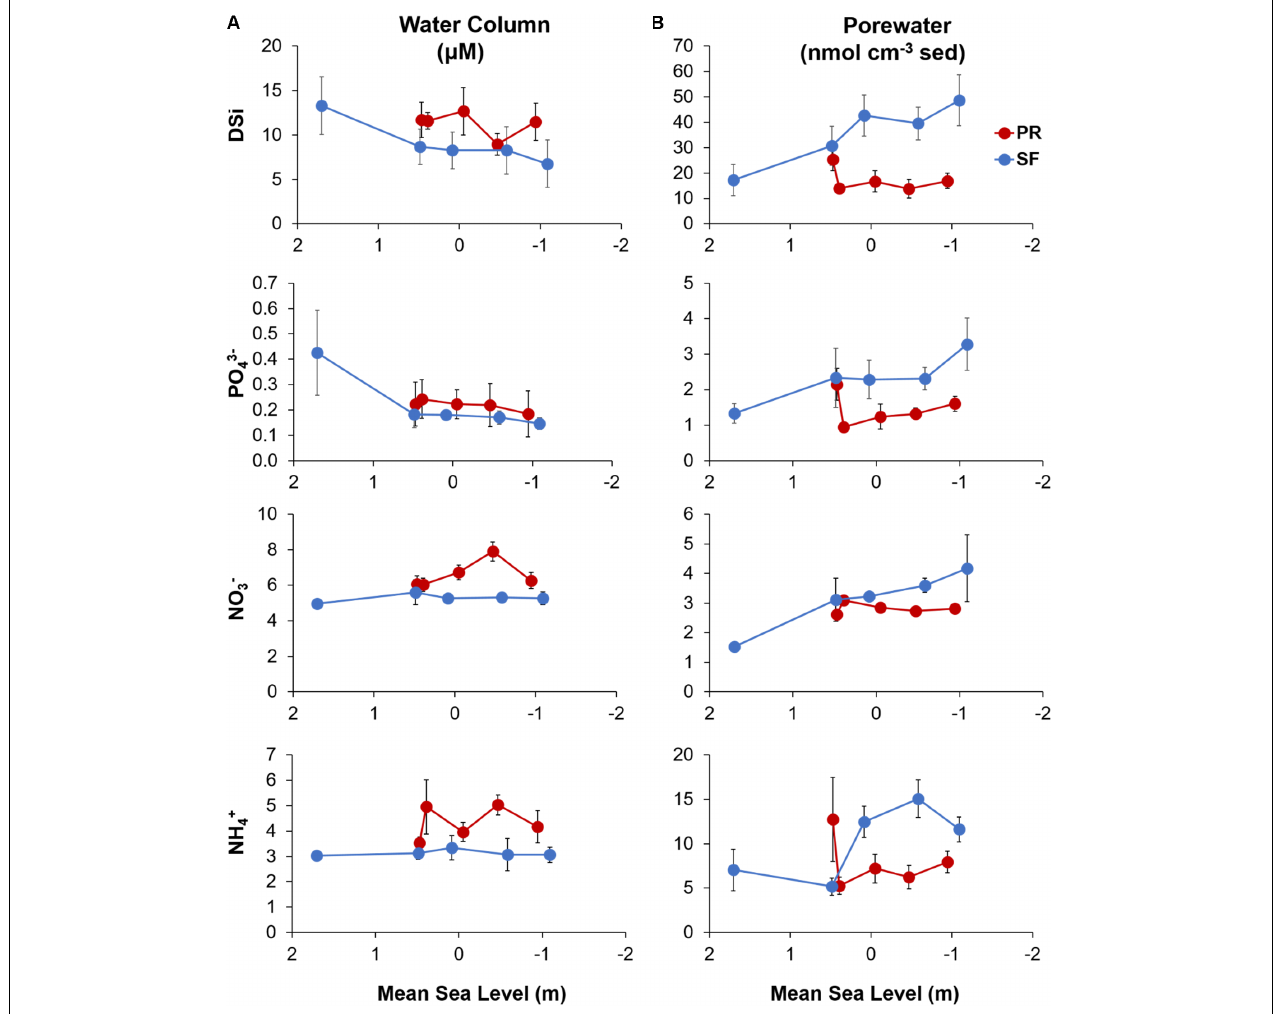
FIGURE 2 | Seasonal mean nutrients concentrations (DSi, NO 3 − , NH 4 + , and PO 43 − ) (A) in the water column and (B) the porewater plotted against mean sea level for the Puerto Real (PR; in red) and San Fernando (SF; in blue) transects. Water column and porewater values represent the mean ± SE ( n =